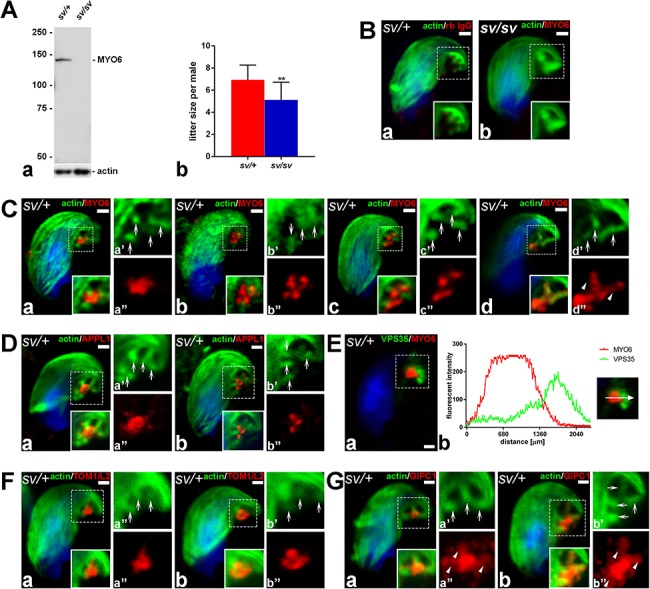
MYO6 localizes together with TOM1/L2 and GIPC1 to APPL1-positive vesicles at TBCs. (A) Immunoblotting of cell extracts from sv/+ and sv/sv testes with anti-MYO6 and anti-actin antibodies (a). Graph showing the quantification of the mean litter size per sv/+ and sv/sv male mouse (b). Both sv/+ (n = 14) and sv/sv (n = 16) males were bred with sv/+ females. **P ≤ 0.01. (B) Stage VII sv/+ spermatid treated with normal rabbit IgG (rb IgG, red) instead of the primary antibodies (a) and stage VII sv/sv spermatid incubated with anti-MYO6 antibody (red) (b). F-actin was visualized with fluorescently labeled phalloidin (green). (C) Confocal images of sv/+stage VII spermatids immunostained for MYO6 (red) and F-actin (green). The boxed area shown in (a) is enlarged and shown in single color in a’ and a”. (D) Confocal microscope images of sv/+stage VII spermatids immunostained for APPL1 (red) and F-actin (green). (E) Confocal microscope image of stage VII sv/+ spermatid immunostained for MYO6 (red) and VPS35 (green) (a) and linear fluorescence intensity values across the TBC region showing the relation between MYO6- and VPS35-positive sub-compartments (b). (F) Confocal microscope images of stage VII sv/+ spermatids immunostained for TOM1/L2 (red) and F-actin (green). (G) Confocal microscope images of stage VII sv/+ maturing spermatids immunostained for GIPC1 (red) and F-actin (green). Arrows highlight the position of the TBCs, arrowheads indicate co-localization between MYO6 or GIPC1 with actin-positive regions of the TBCs, and dotted squares indicate areas magnified in images marked with prime and double prime. All bars 1 μm.